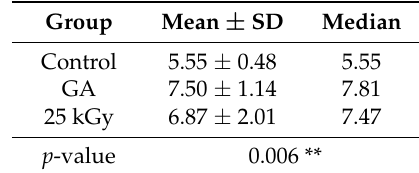
Figure 6. µ CT images of ( a ) control, ( b ) GA and ( c ) 25 kGy. ( d ) New bone volume of each group at 4 weeks after surgery (mm 3 ). The symbol “*” indicates statistical significance between the two groups (* p < 0.05). Table 1. New bone volume within regions of interest (mm 3